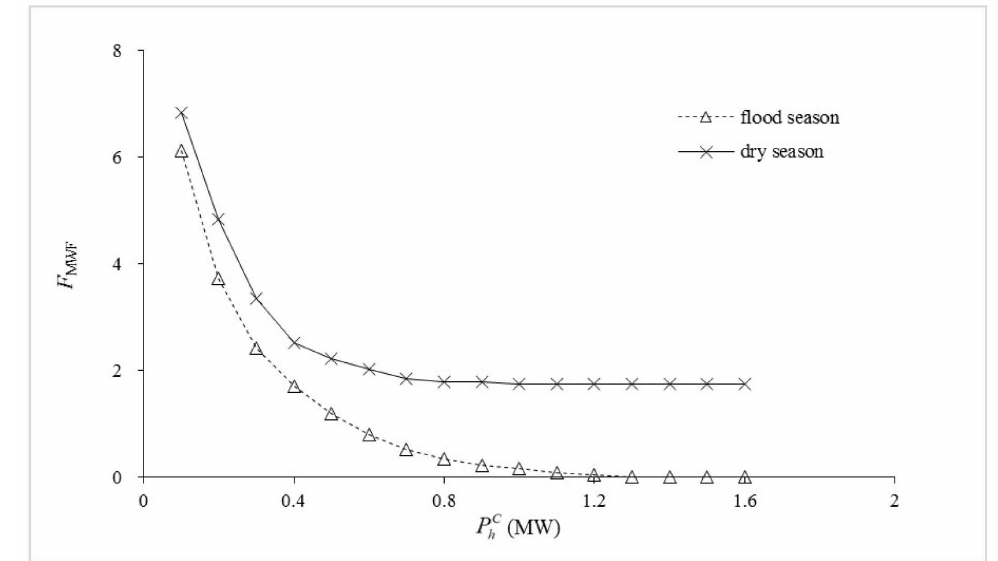
Figure 12. Combined power fluctuation index vs. hydropower capacity in different water resource